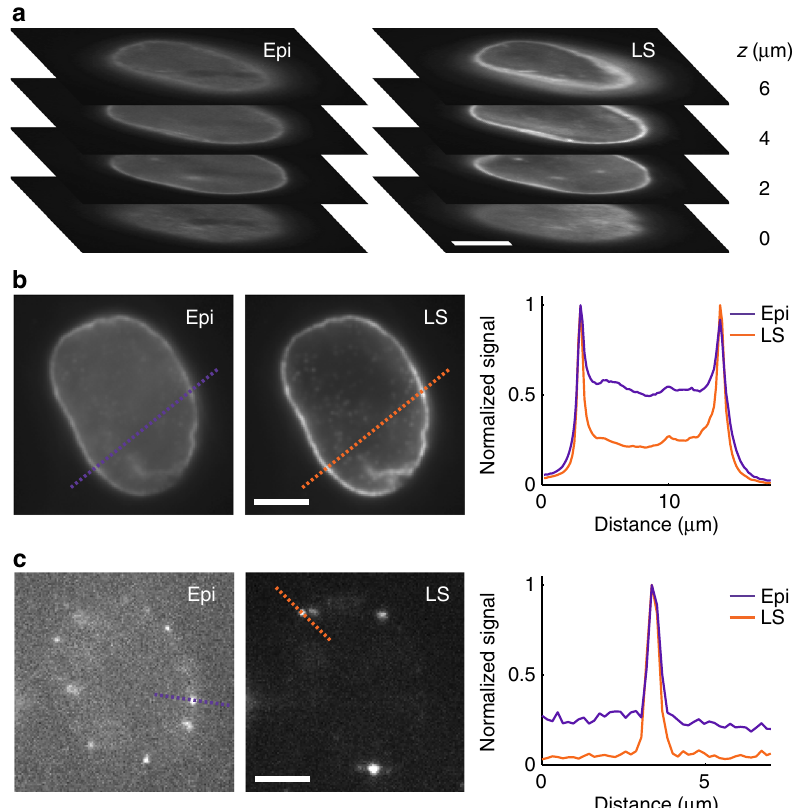
Fig. 3 Sectioning using light sheet illumination improves contrast in 2D imaging. a Comparison between epi- (Epi) and light sheet (LS) illumination at different z -positions throughout a cell nucleus. The image plane was moved using the piezoelectric objective scanner, and for LS imaging the LS plane was moved together with the image plane using the motorized mirror. The sectioning capability of the LS is clearly demonstrated, showing an improved contrast when compared with epi-illumination for all cell sections. b Diffraction-limited and c single-molecule images demonstrating that light sheet illumination improves the signal-to-background ratio up to fi vefold compared to conventional epi-illumination. Graphs show line scans over the dashed lines in the images. All images show lamin B1 immunolabeled with Alexa Fluor 647 in HeLa cells. Compared images are shown with the same linear grayscale, respectively. Scale bars are 5 µ